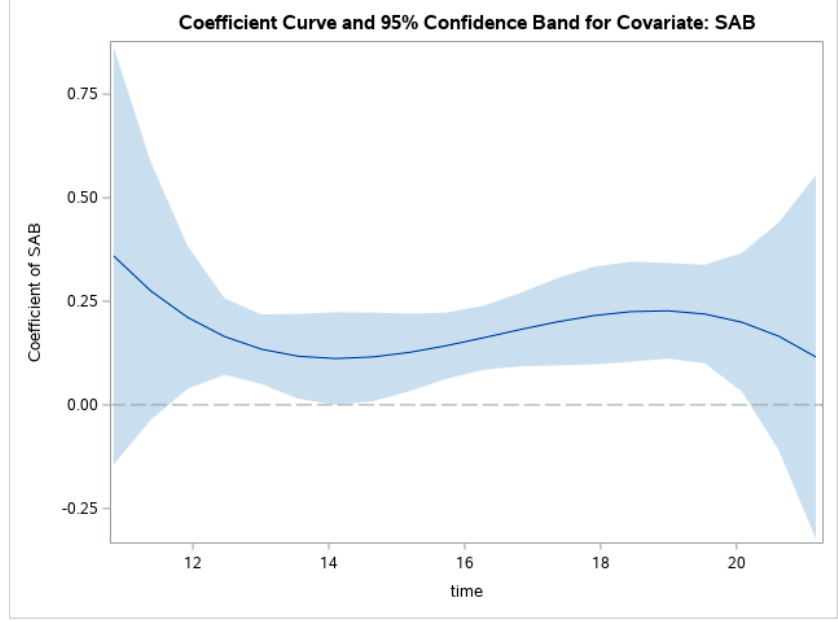
Figure 2. Changes in relations between SAB and GHQ through adolescence.